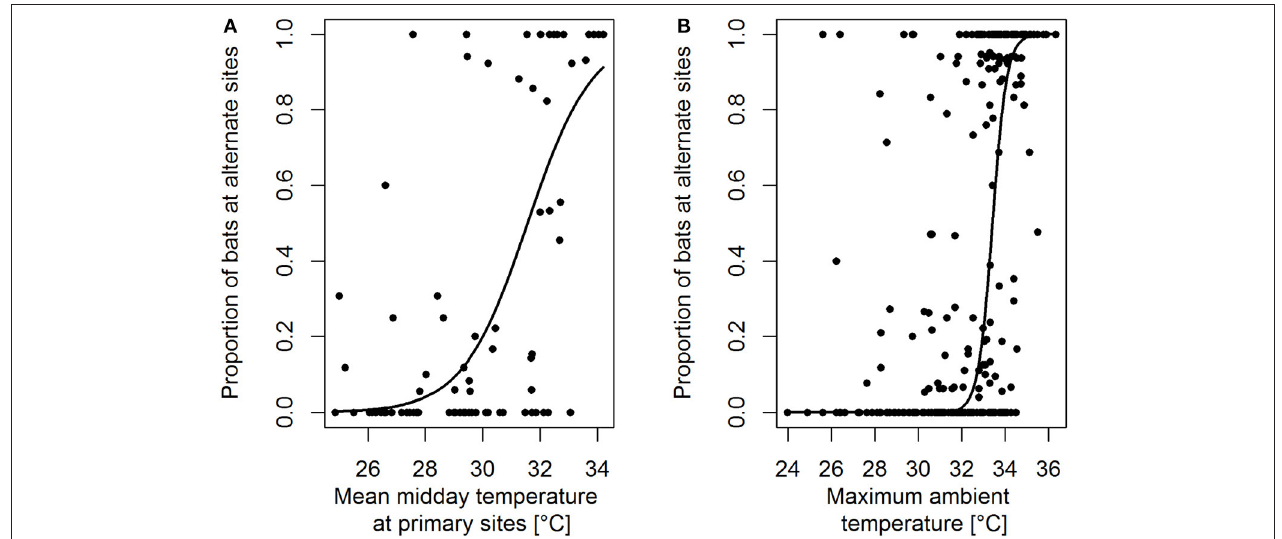
FIGURE 2 | The proportion of bats in alternate roost sites during midday and/or afternoon increases as a function of (A) mean midday roost site temperature at the primary site (iButton and site-use data for CL, CR 2015 and CL, CR, CG, RS 2016) and (B) daily maximum ambient temperature (La Selva meteorological station data and site-use data for CL and CR 2013–2014). The black lines represent the fitted lines from binomial GLMMs.